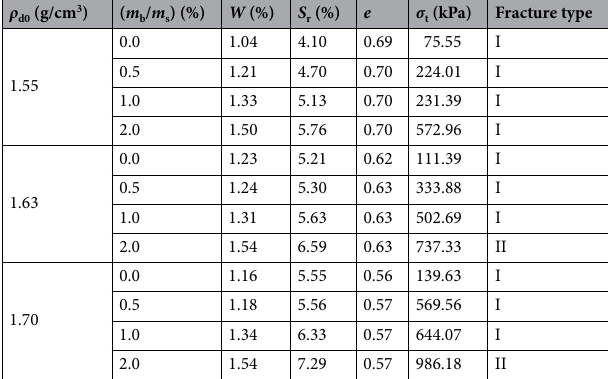
Table 3. Summary of splitting tension tests data.